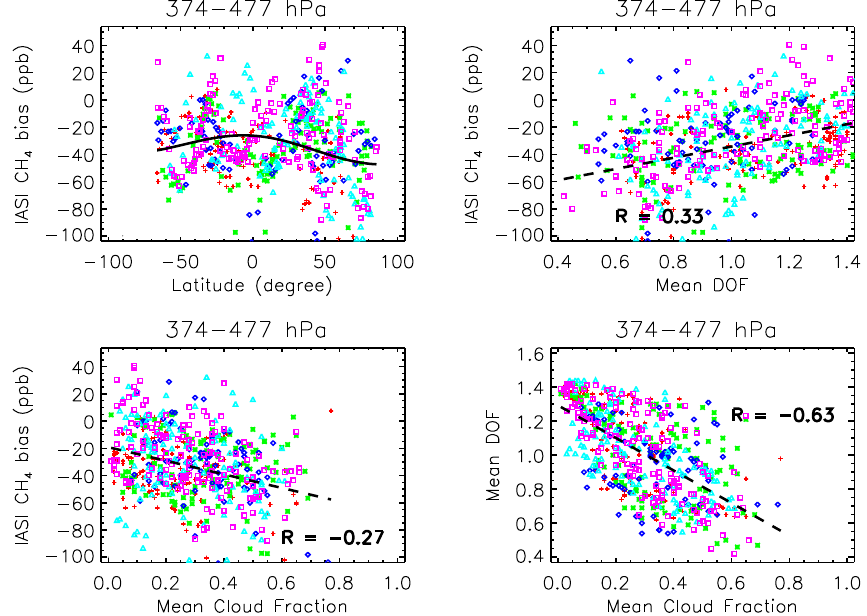
Fig. 10. Dependence of the IASI CH 4 retrieval bias in layer 374–477hPa on latitude (the solid line is the second-order polynomial fitting of the error with latitude), and correlation between the IASI CH 4 retrieval bias and mean degrees of freedom (DOF) and cloud fraction, and correlation between the mean DOF and cloud fraction. Similar results are found for other trapezoids. Different colors are for different campaigns as defined in Fig.